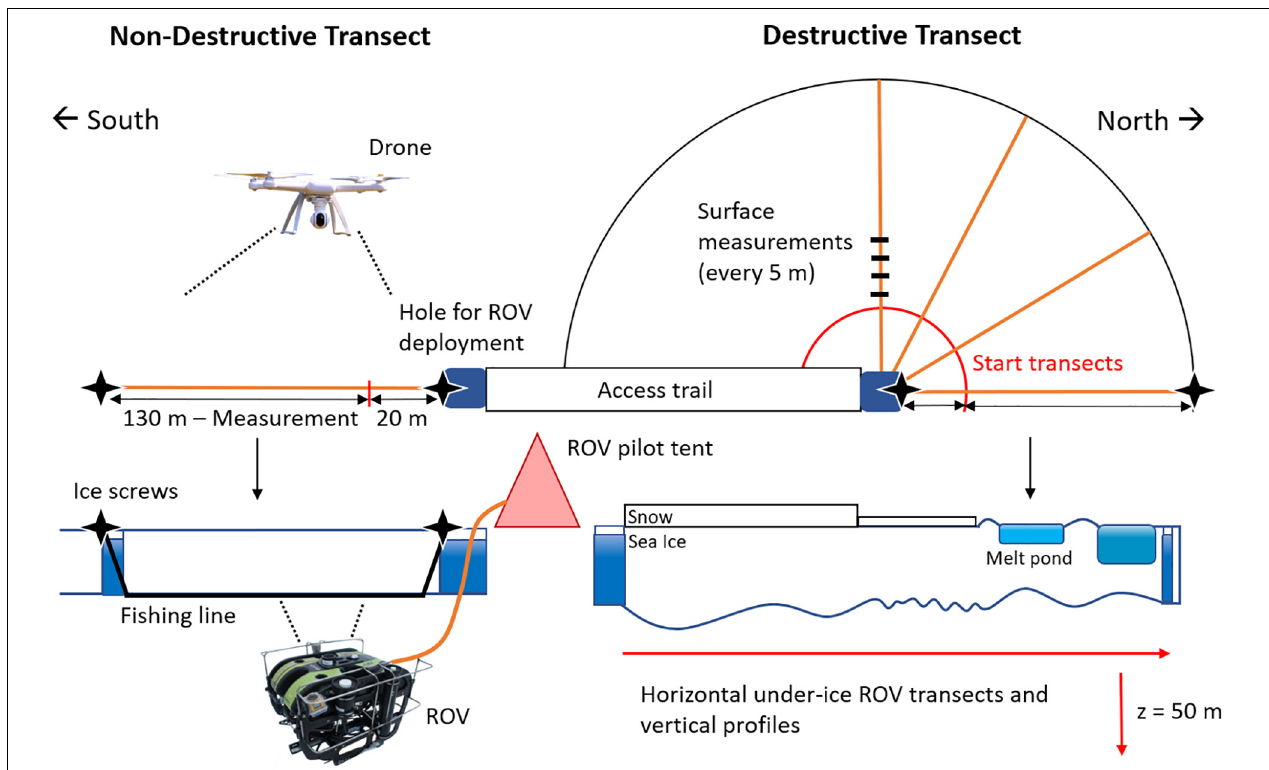
FIGURE 2 | Schematic sampling set-up of under-ice ROV measurements and ice surface measurements in the two (non-destructive, destructive) transect areas.